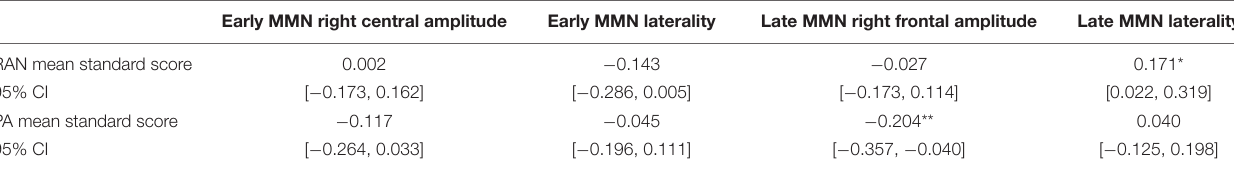
TABLE 3 | Partial correlations among PA and RAN measures and MMN